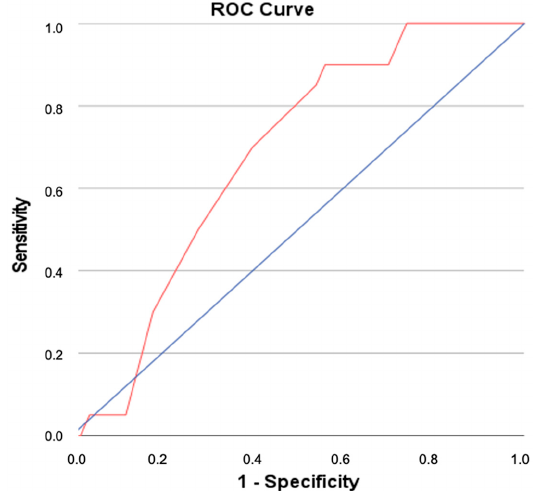
Figure 3. Receiver–operator curve for LRINEC for predicting (Area under the curve was 0.677 ( p -value = 0.021)) lethality.